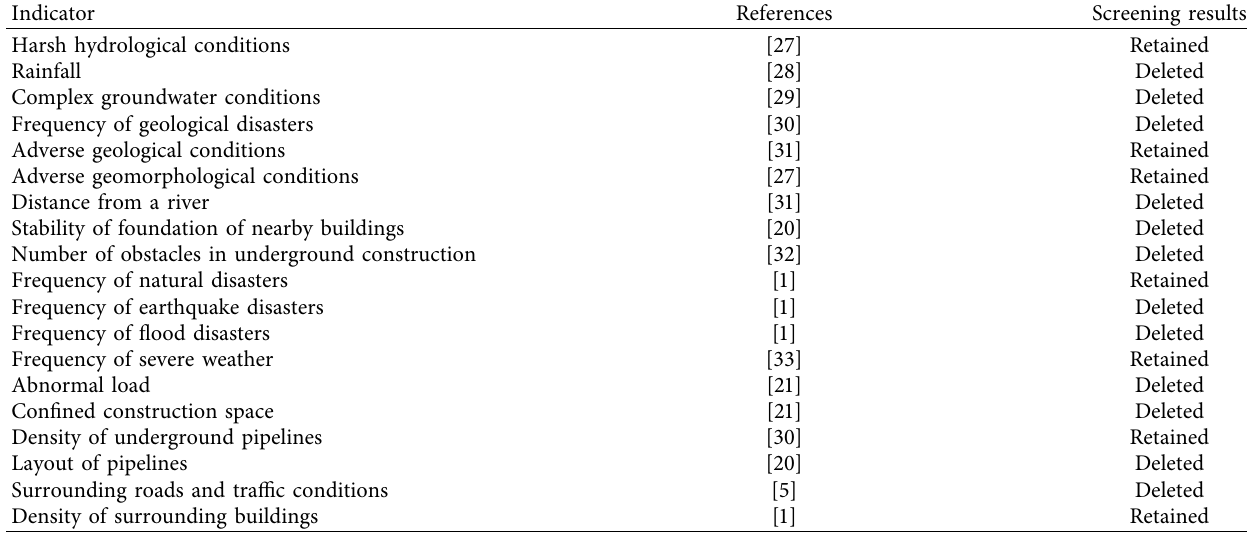
Table 1: Initial index system of environmental risk assessment for subway station engineering.